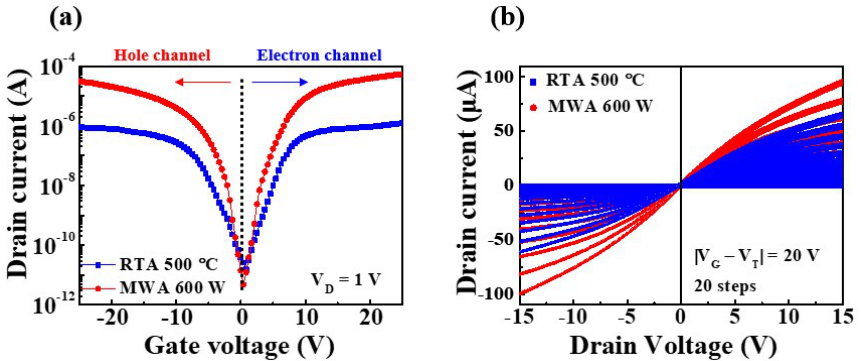
Figure 7. The transfer curves (a) and output curves (b) of the 600-W MWA and 500-°C RTA NiSi x SB-TFTs.